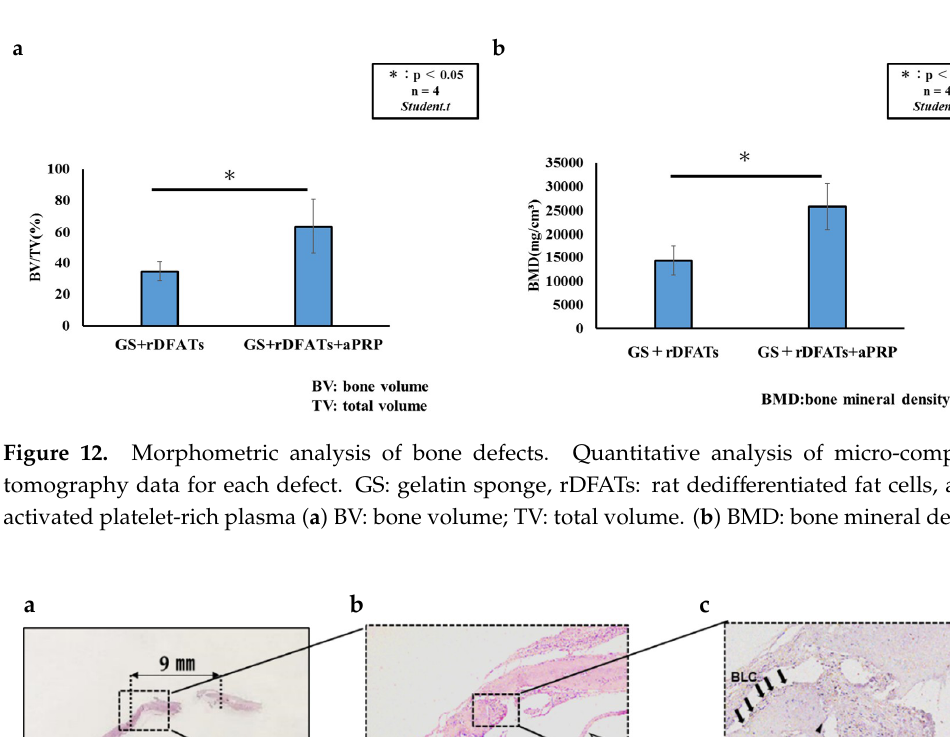
11 of 15 Figure 11. Micro‐computed tomography analysis and microscopic images of the defects. Representative macroscopic images of the defects treated with sponges after implantation surgery at 4 weeks. ( a , b ) Axial and coronal bone mineral density (BMD) image, reconstructed by a three‐